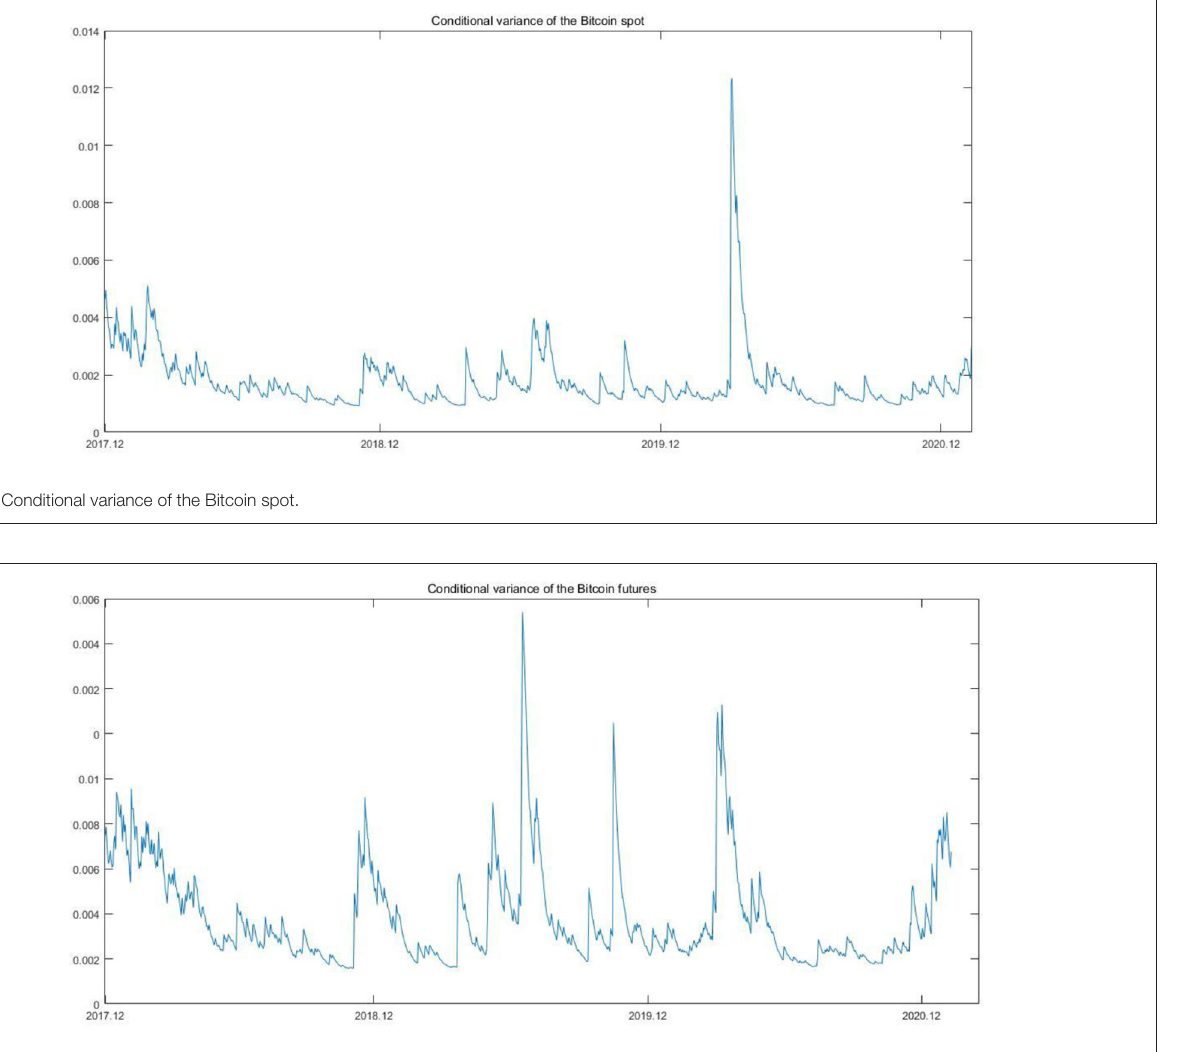
FIGURE 3 | Conditional variance of the Bitcoin